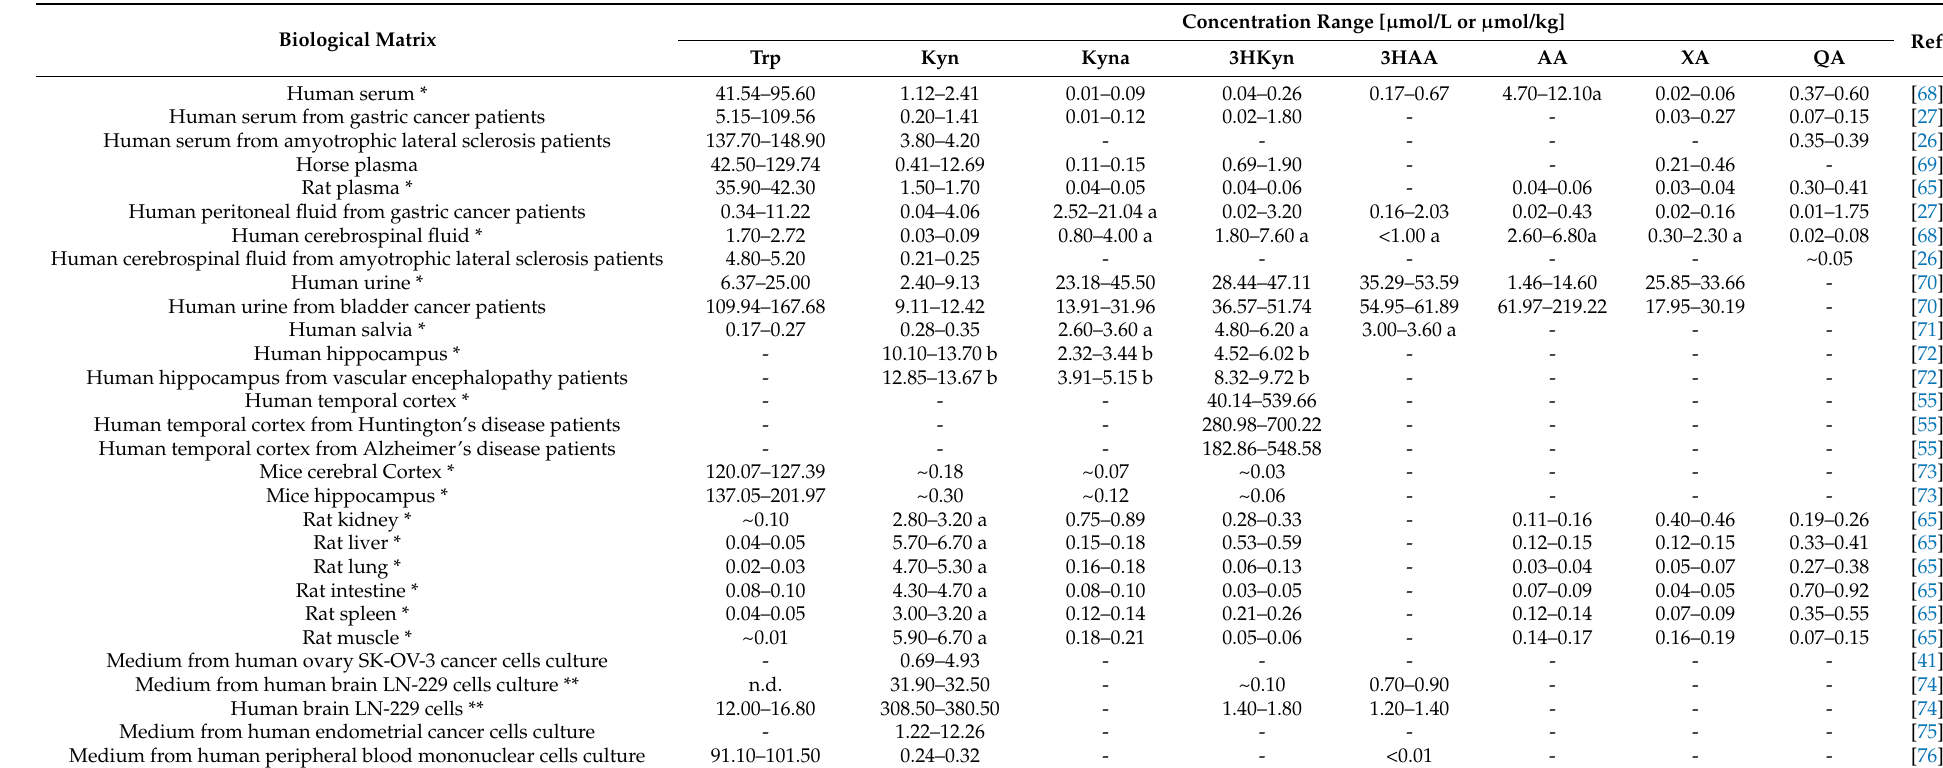
Table 2. Comparison of concentrations levels of tryptophan and kynurenine pathway metabolites in biological